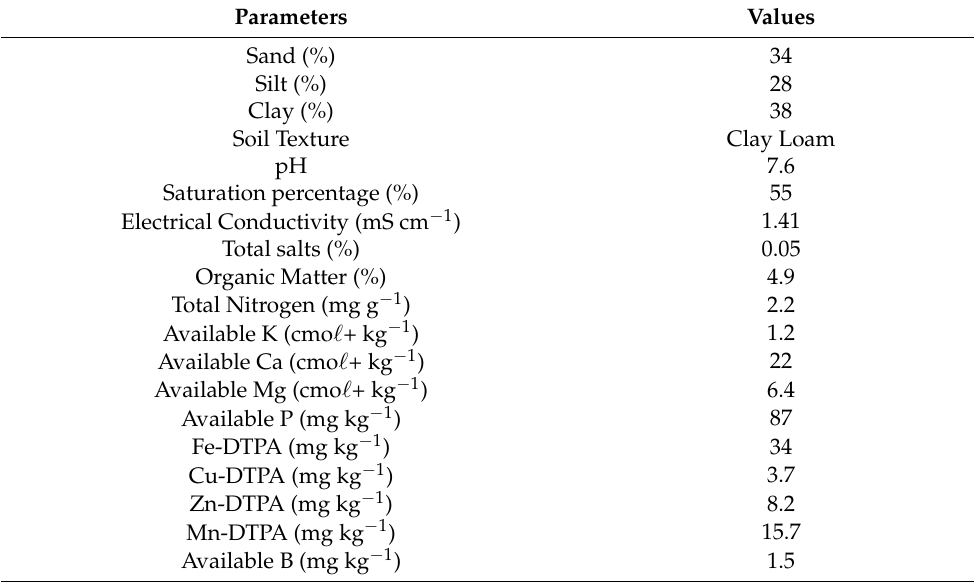
Table 2. Physical and chemical properties of